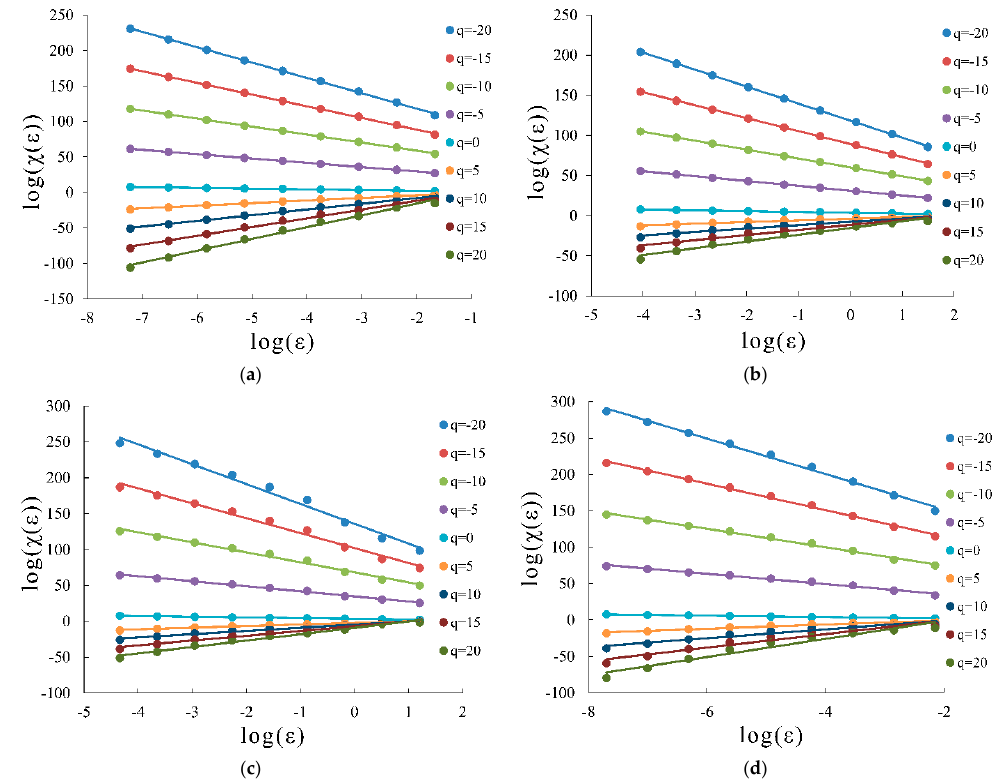
Figure 5. Plots of μ ( ε ) versus box size, ε , for the pore size distribution. ( a ) Sample 52; ( b ) Sample 64; ( c ) Sample 72; ( d ) Sample 142.